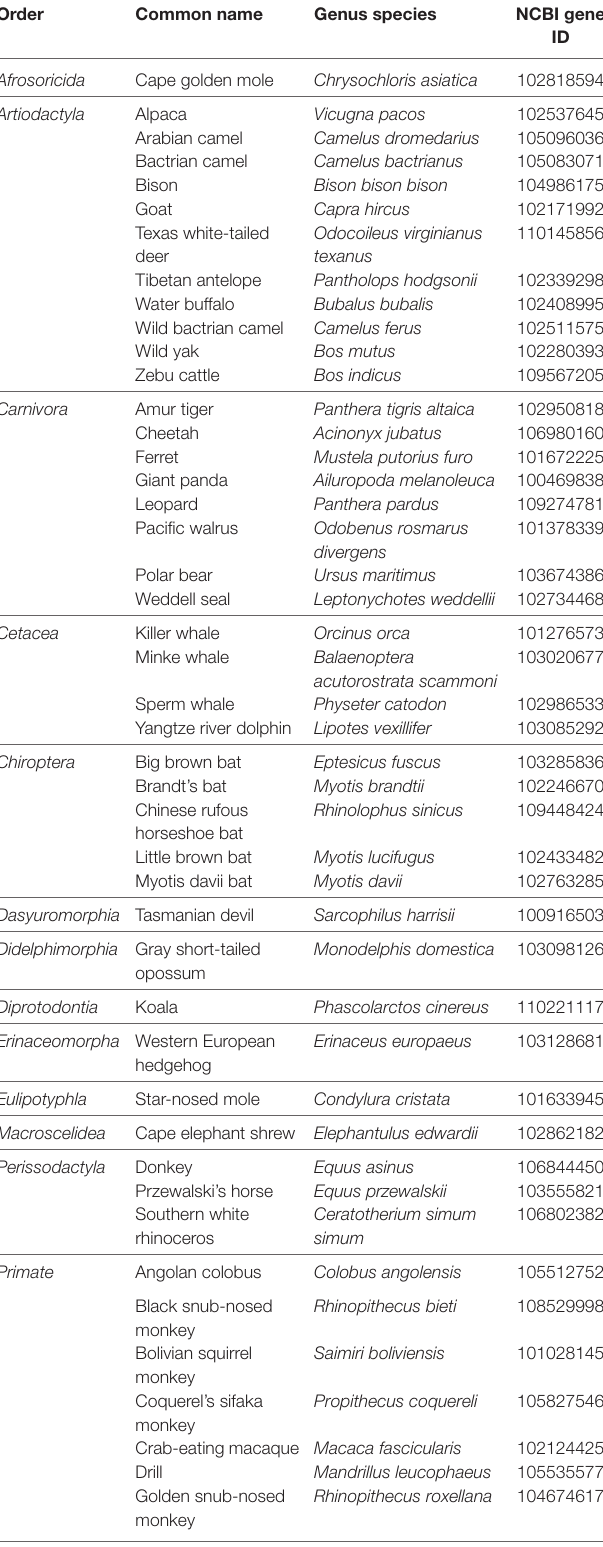
TABLe 2 | Identification of the GnRH2 gene within 68 additional mammals via NCBI gene database queries.